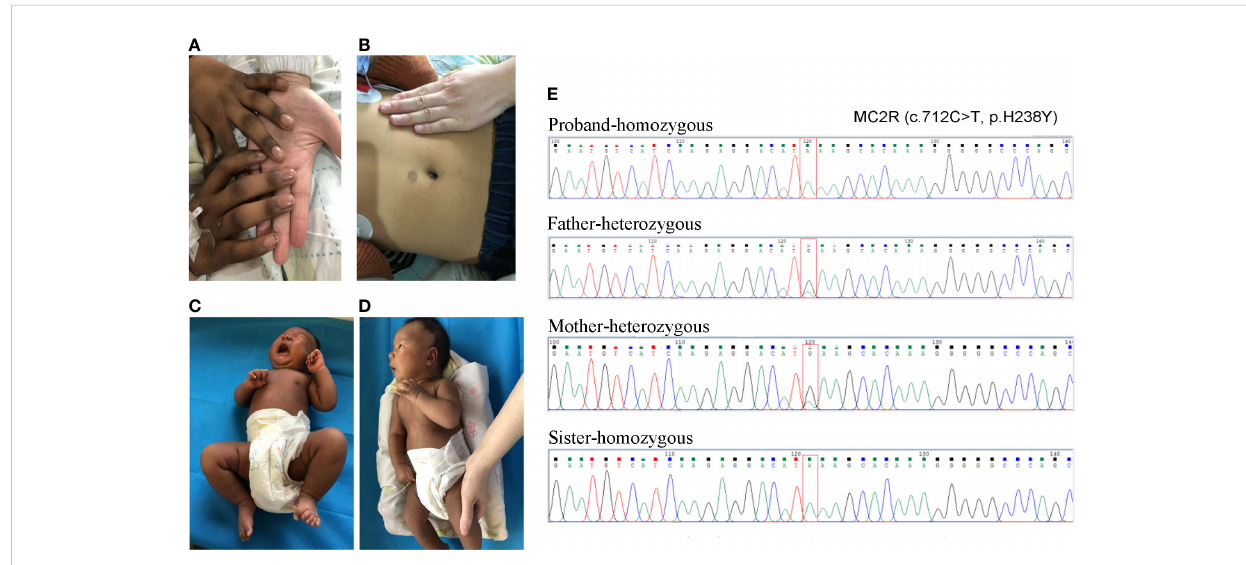
FIGURE 1 The skin pigmentation and the results of Sanger sequencing. (A, B) The skin pigmentation of the brother; (C, D) The skin pigmentation of the sister. (E) Sanger sequencing results of the